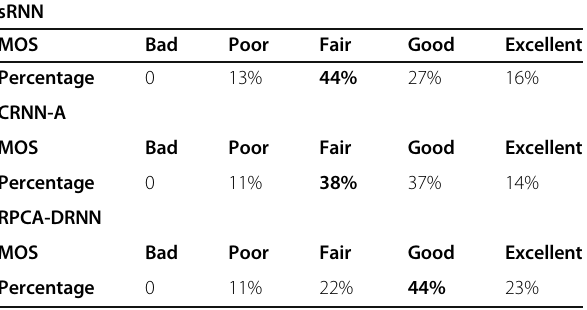
Table 4 Percentages of bad, poor, fair, good, and excellent MOS scores assigned to singing voice clips separated using sRNN, CRNN-A, and RPCA-DRNN on MIR-1K